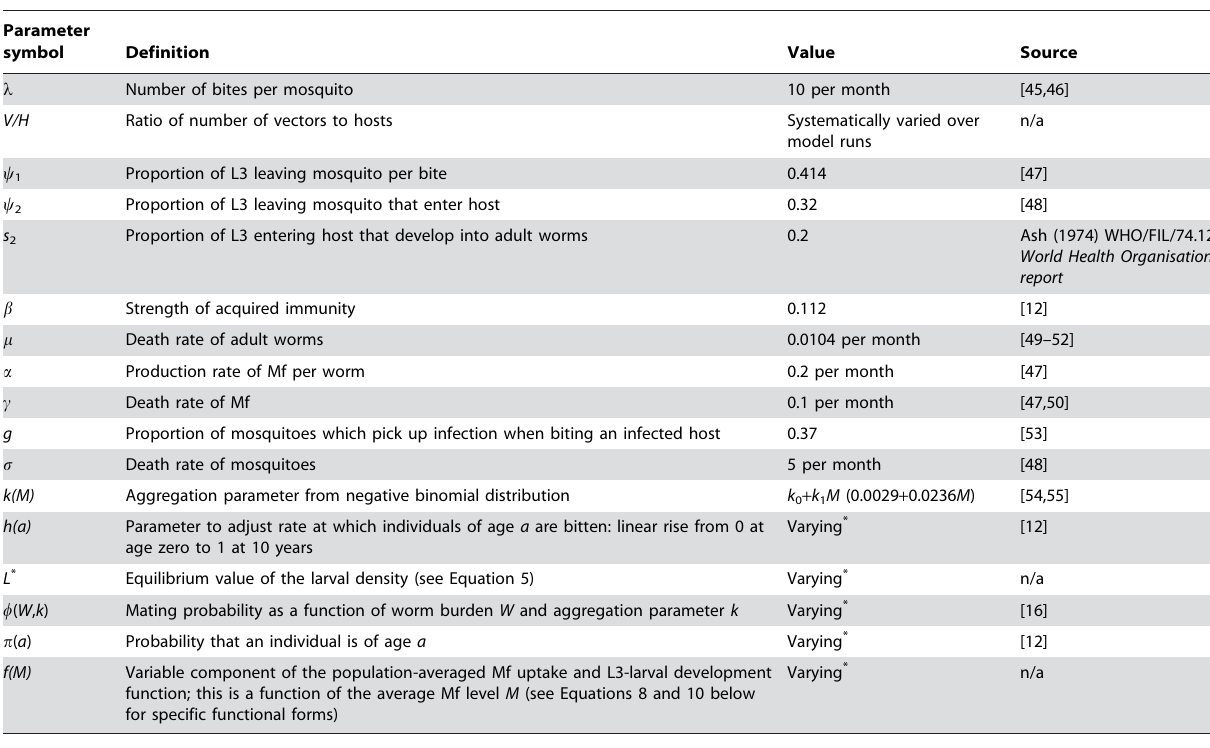
Table 1. Description and values of the parameters of the model.